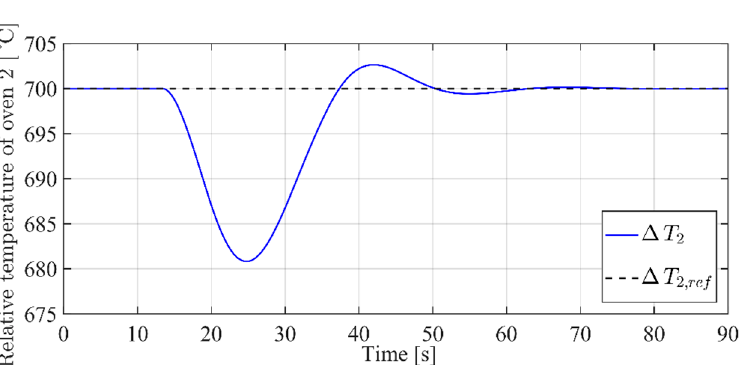
Figure 6. 𝛥𝑇 (cid:2869) time profile. Figure 7 𝛥𝑇 (cid:2870) time profile.